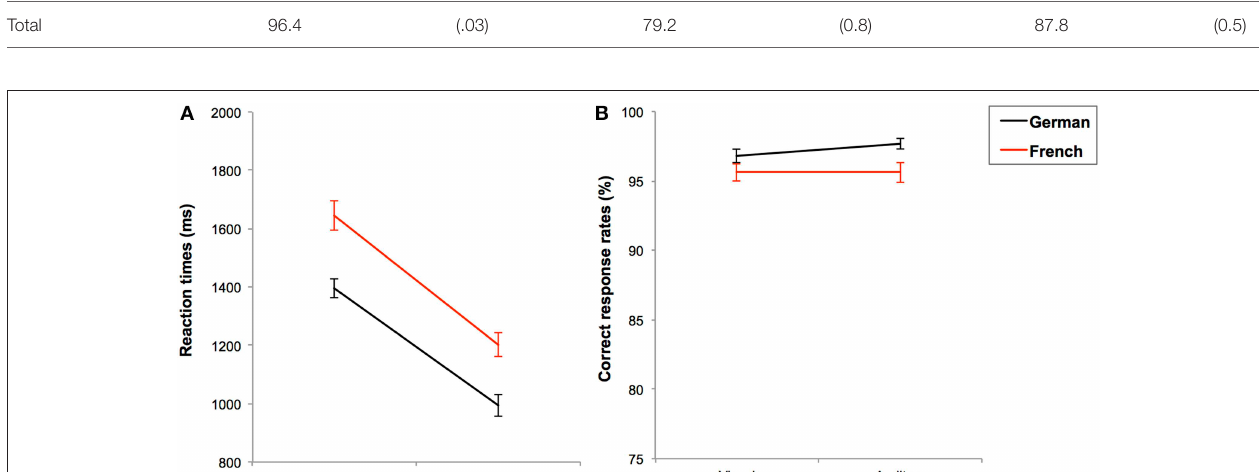
FIGURE 1 | Mean reaction times in ms (A) and mean correct response rates in percentages (B) with standard errors for the simple additions in each task language (black line for German and red line for French) as a function of presentation format.